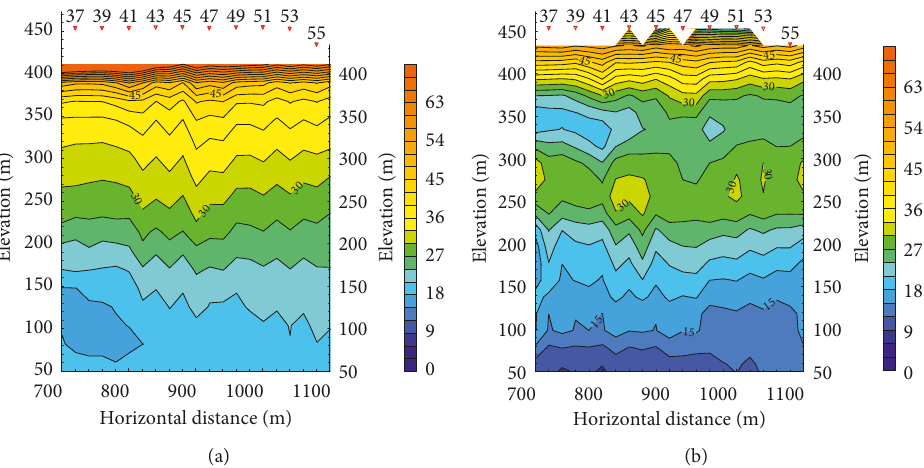
Figure 9: Different data processing methods for transient electromagnetic exploration. (a) Late formula for calculating the resistivity section. (b) Inversion method for calculating the resistivity section.